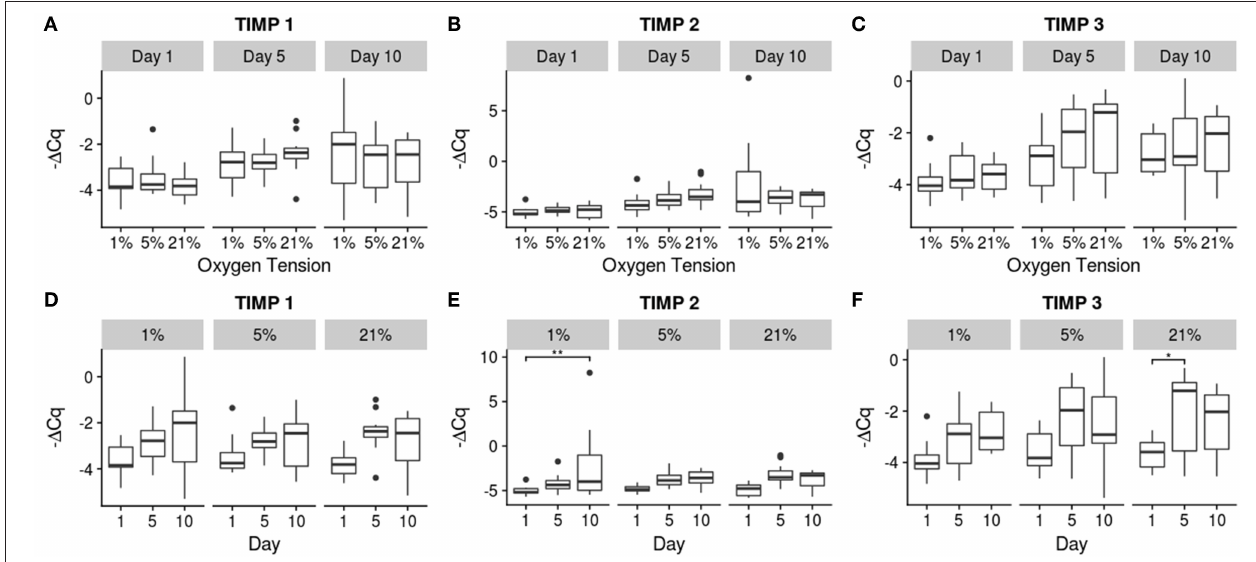
FIGURE 6 | Gene expression of the catabolic inhibitor genes using - 1 Cq values. The top row (A–C) contains between oxygen tension group comparisons over the days, while the bottom row (D–F) contains changes over time within each oxygen tension group. Significance shown as * p ≤ 0.05 and ** p ≤ 0.01.